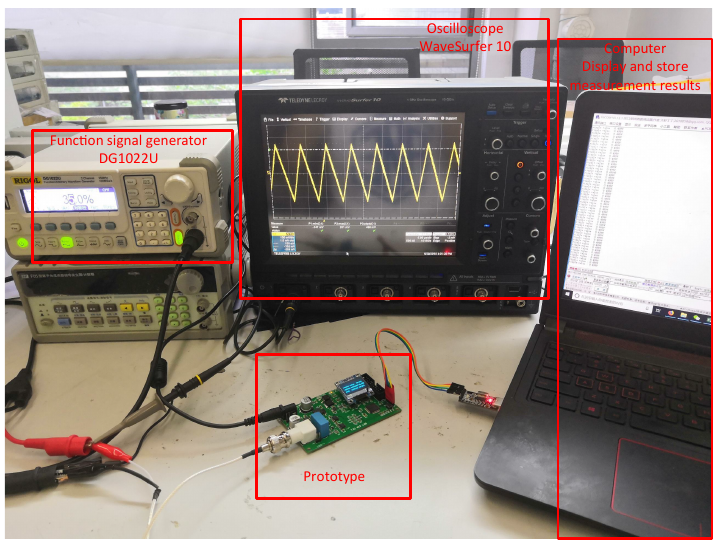
Figure 9. The experimental